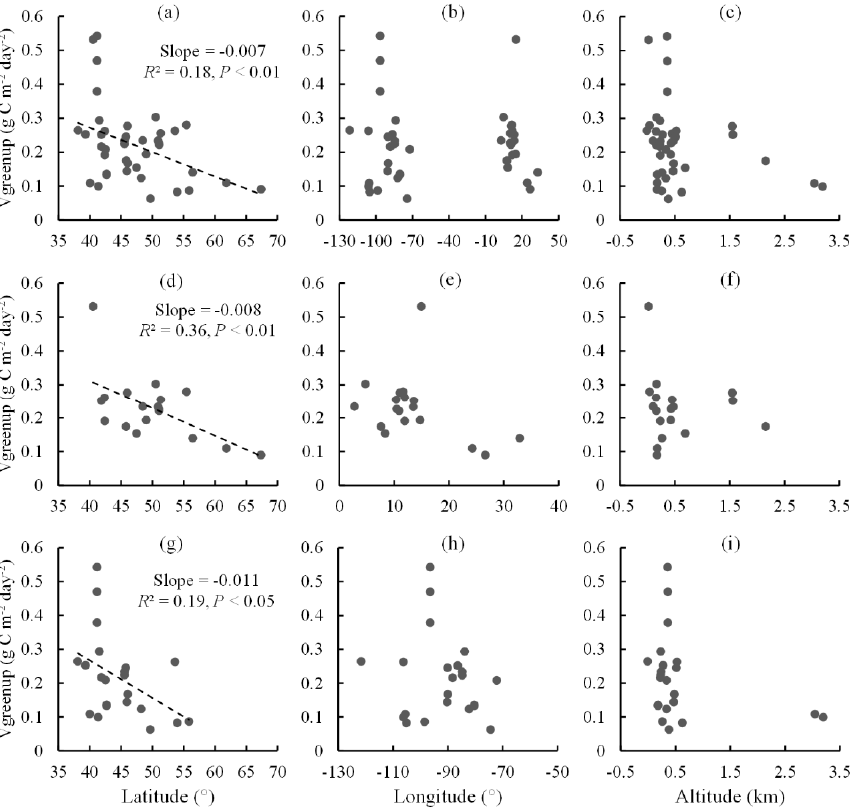
Figure 2. The relationships between Vgreenup and geographical factors. ( a − c ) The geographical patterns of Vgreenup across all sites in Europe and North America; ( d − f ) the geographical patterns of Vgreenup across all sites in Europe; ( g − i ) the geographical patterns of Vgreenup across all sites in North America.